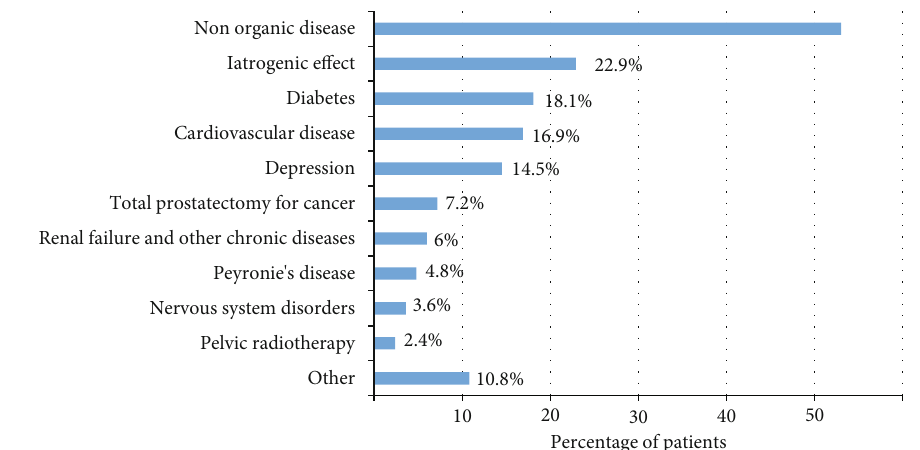
Figure 1: Aetiology of ED in the analysed population. The most frequent cause of ED is a nonorganic disease, followed by iatrogenic e ff ects and